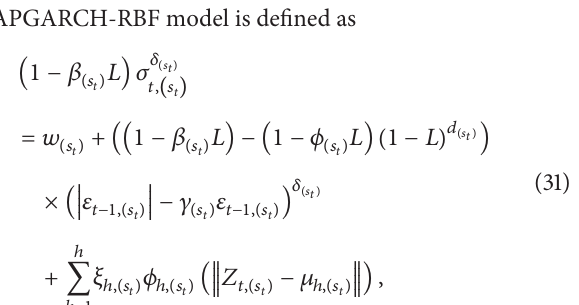
0 ≤ 𝛾 ≤ 1 . Further, (𝑠 𝑡 )